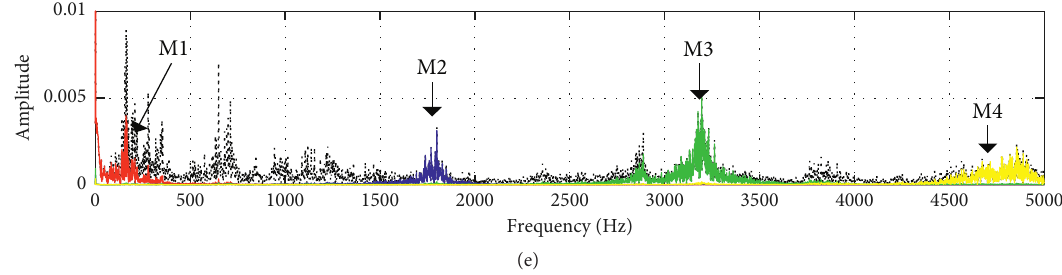
Figure 30: The meaningful modes iteratively extracted by the extension method: (a) mode 1, (b) mode 2, (c) mode 3, (d) mode 4, and (e) their Fourier spectra.